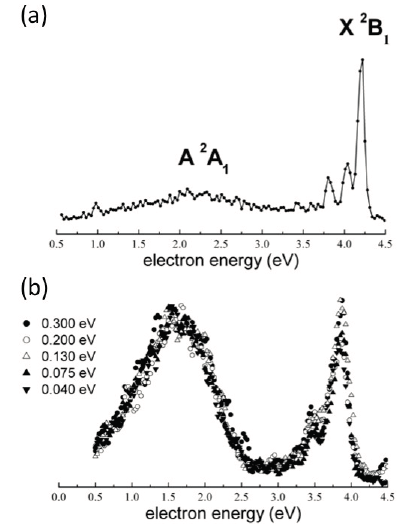
Figure 2. The obtained ( a ) PES (upper panel) and ( b ) PIES (lower panel) spectra in photoionization and Penning ionization studies of water molecules using Ne(I) photons and Ne * ( 3 P 2,0 ) metastable atoms, respectively. The PIES spectra reported in the lower panel are recorded at five different collision energies (0.300, 0.200, 0.130, 0.075, and 0.040 eV), by varying the nozzle temperature (between 300 and 700 K) of the supersonic source and by using, besides pure neon, two different Ne:H 2 mixtures (50:50 and 20:80 ratios). By looking at the relative position of the corresponding peak maxima in the PES and PIES spectra, it is possible to evaluate the evident negative energy shifts ( − 140 meV and − 300 meV for X 2 B 1 and A 2 A 1 electronic states of H 2 O + , respectively) that depend on the binding energy of the autoionizing collision complex (see the